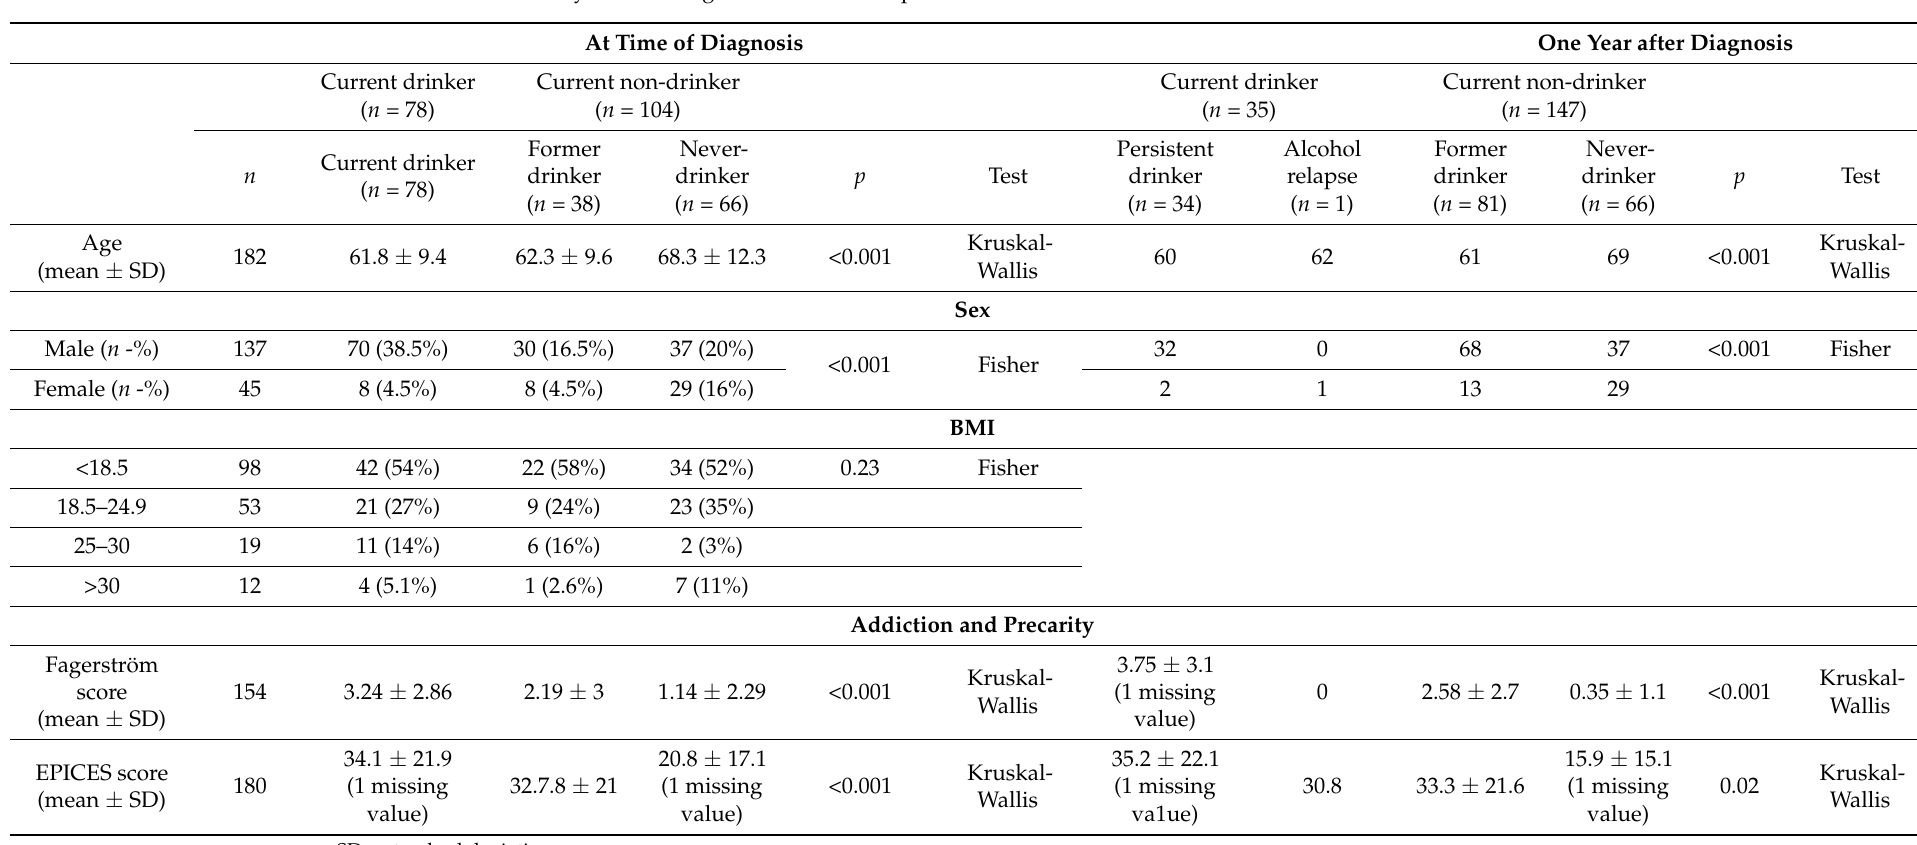
Table 3. Univariate analysis according to alcohol